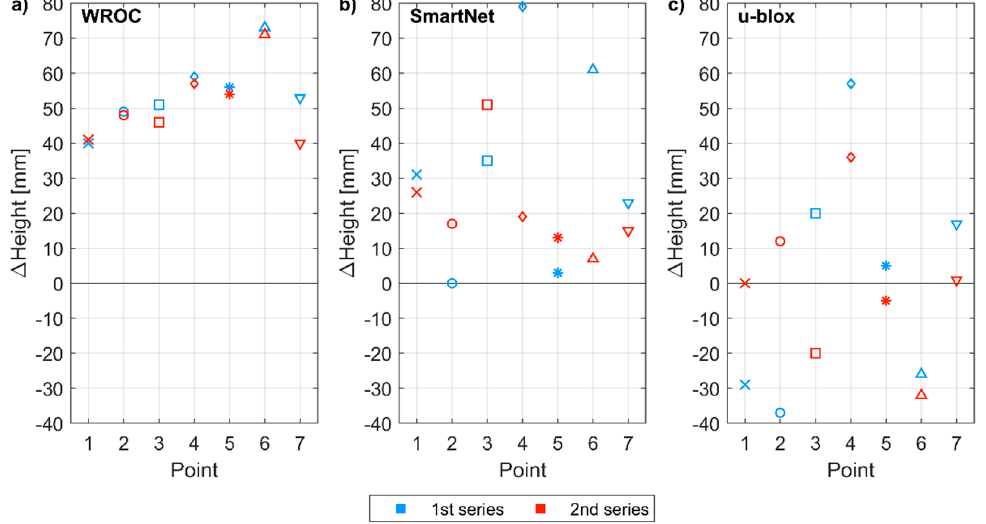
Figure 11. Positioning error for height (with respect to reference coordinates) of control points measured in two series by using: ( a ) WROC station as reference station; ( b ) NRTK SmartNet; ( c ) u-blox receiver as a base station.